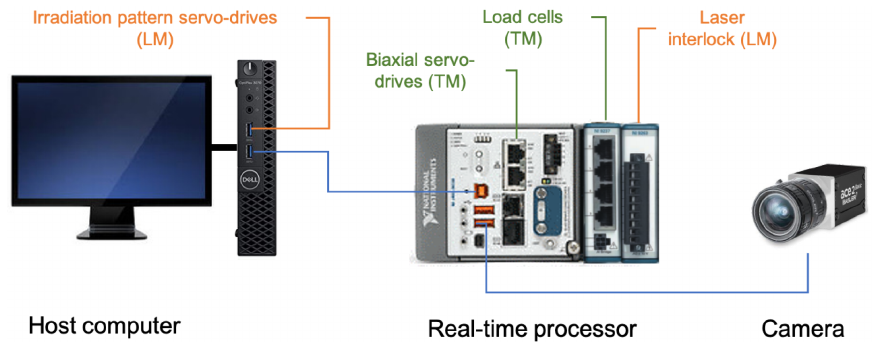
Figure 4. Schematic of the hardware connections for the acquisition/control module (ACM)